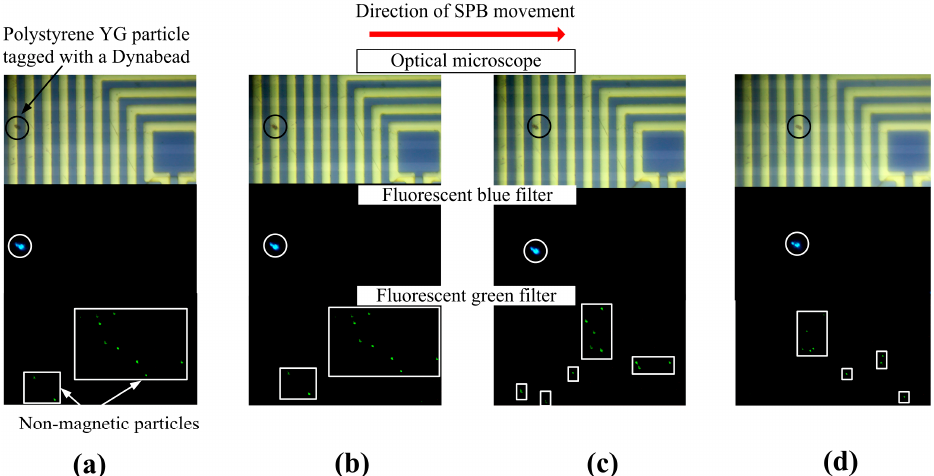
Figure 6. Transportation of a polystyrene YG particle tagged with a Dynabead ® in a heterogeneous solution (the tagged particle is circled while the unattached polystyrene PC particles are enclosed in squares/rectangles) from ( a ) the outermost loop of loop set 3 to ( b ) outermost loop of loop set 2 to ( c ) outermost loop of loop set 1 and ( d ) back to part of loop set 3 The average time taken for a COMPEL™ bead to move to the innermost loop from its adjacent loop was 8.1 ± 2.2 s. The average times taken for a Dynabead ® with and without a bound polymer